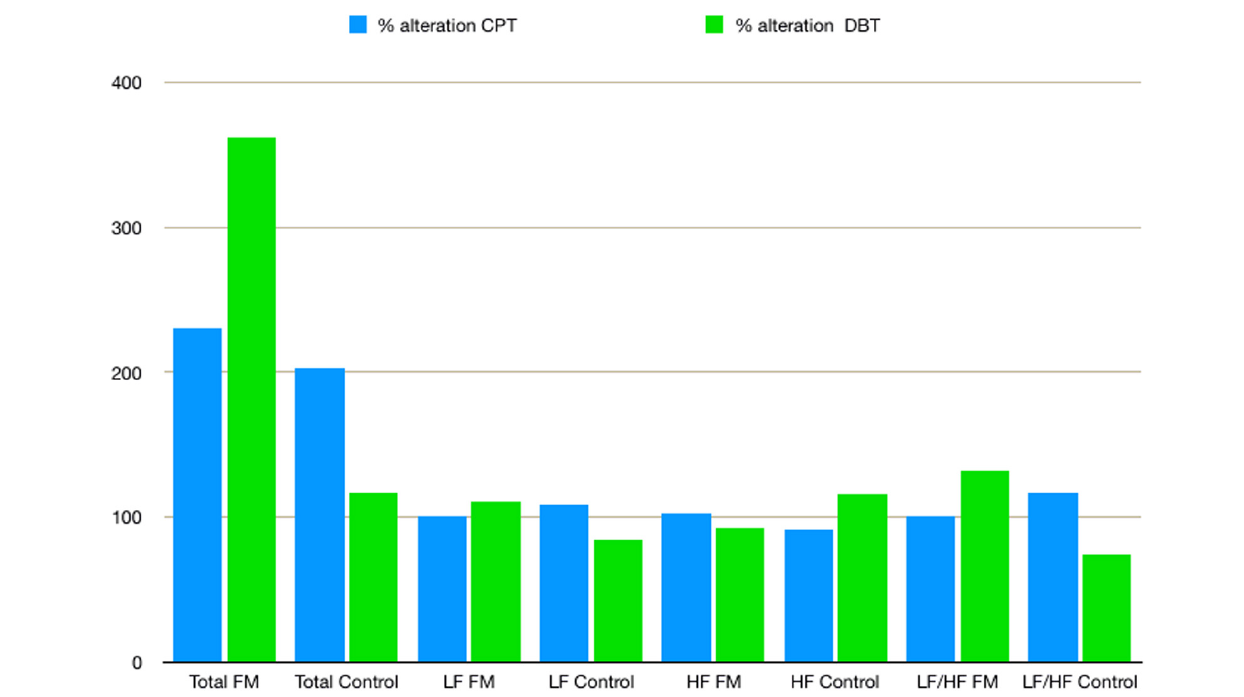
TABLE 4 | Comparison of deep breathing test parameters between two study groups, fibromyalgia patients and control.